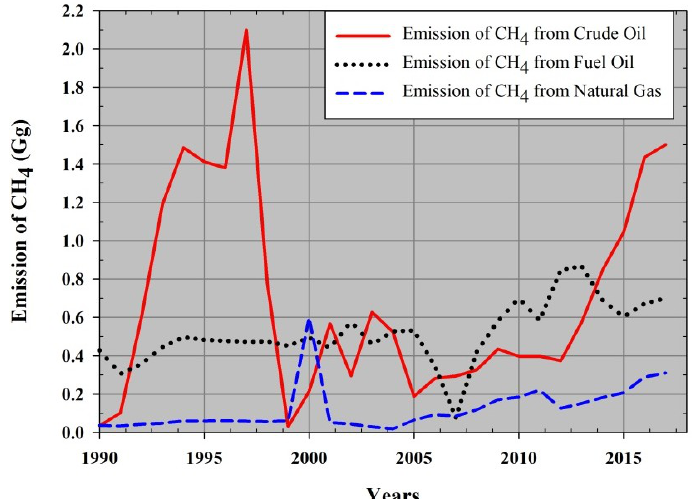
Figure 6. CH 4 emissions from the consumption of crude oil, fuel oil, and natural gas in electricity generation from 1990 to 2017.